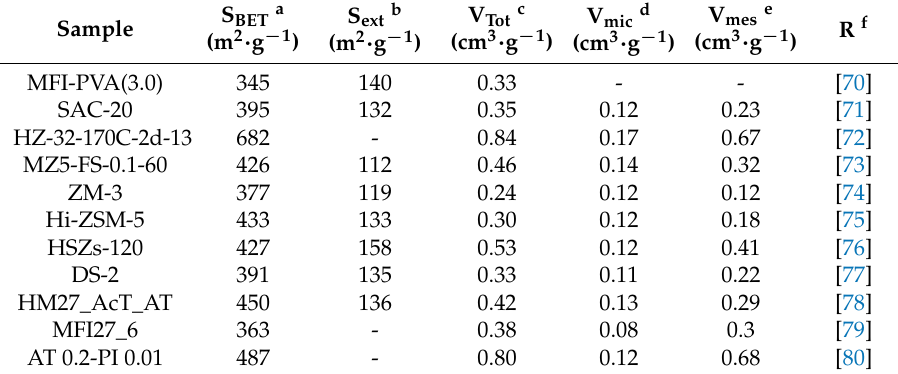
Table 3. Textural properties of hierarchical ZSM-5 zeolite in the